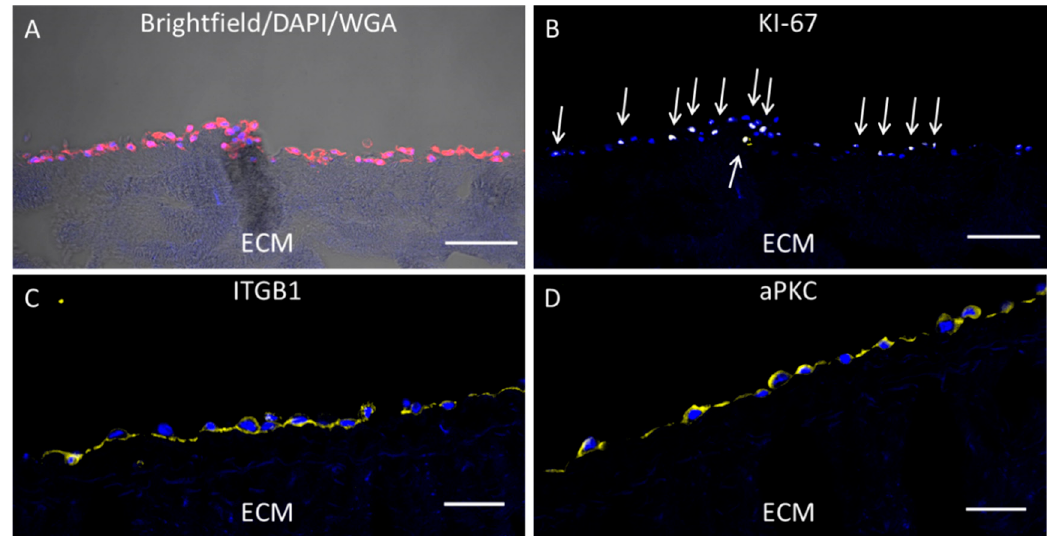
Figure 1. Cultivation of primary human keratinocytes (NHEK) on decellularized extracellular matrix (ECM). The 8 µm sections of ECM were analyzed by microscopy. NHEK grown on decellularized ECM for 2 days were treated with CF594 (red) coupled wheat germ agglutinin (WGA) for staining of sialic acid. N-acetylglucosamin on cell membranes and ECM structure was visualized with a brightfield channel ( A ). After permeabilization, KI-67 ( B ) as a proliferation marker (proliferative cells indicated by arrows), integrin beta 1 (ITGB1) as basal polarization marker ( C ) and the atypical protein kinase C (aPKC) as apical polarization marker ( D ) were visualized with polyclonal antibodies and AF647 (yellow) coupled anti-rabbit secondary antibodies. Cellular nuclei were counterstained with DAPI (blue). Scale bar = 100 µm.